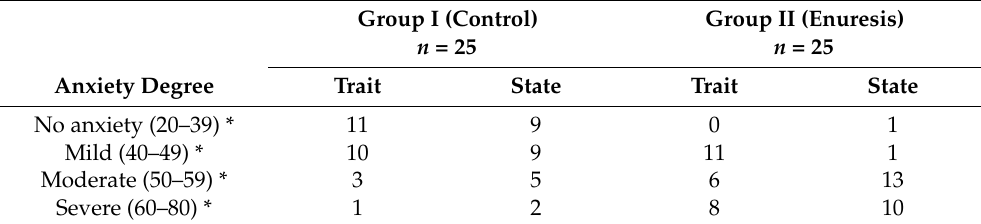
Table 2. Trait anxiety and state anxiety frequencies in each group.